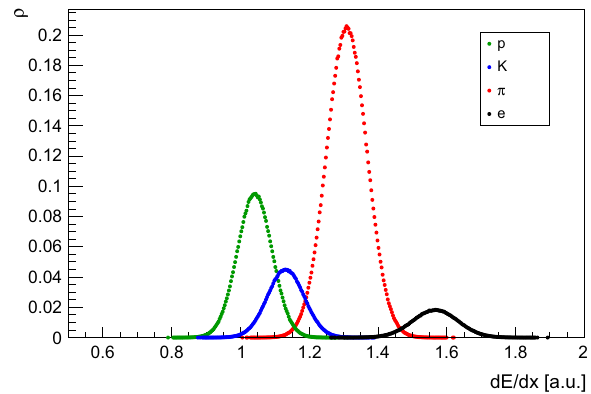
Fig. 2 Generated dE / dx distribution in a single bin. For details see text